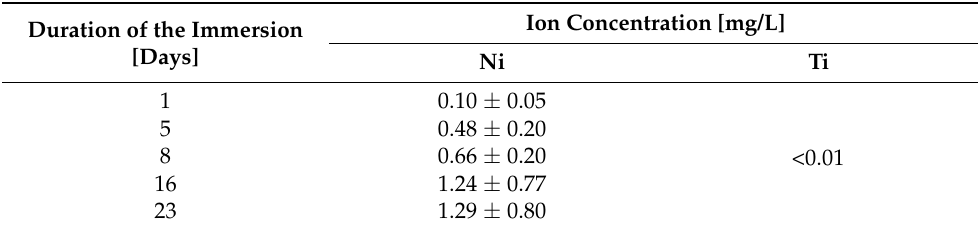
Table 2. Results of the ion concentration in the Ringer solution from the NiTi. Statistical analysis was calculated based on five repetitions and was calculated as the standard deviation.